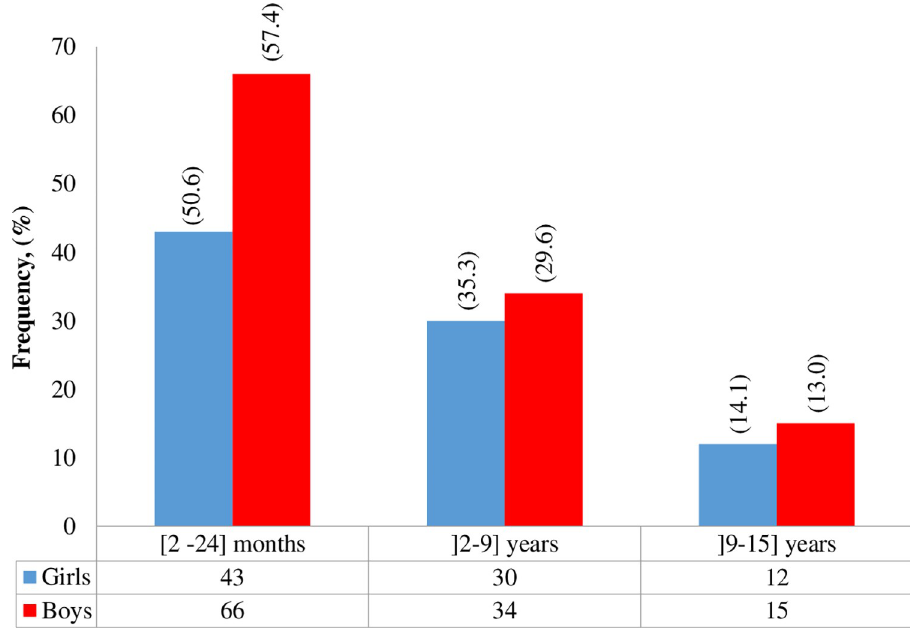
Fig 1. Description of the population studied according to gender and age